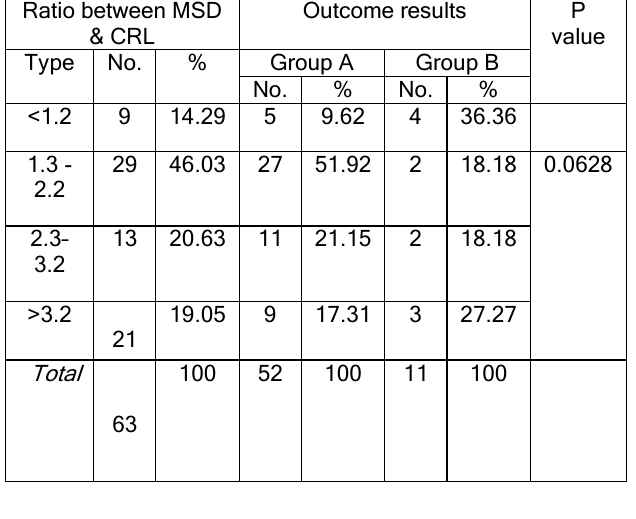
Table (4): The MSD : CRL ratio in the study groups Ratio between MSD